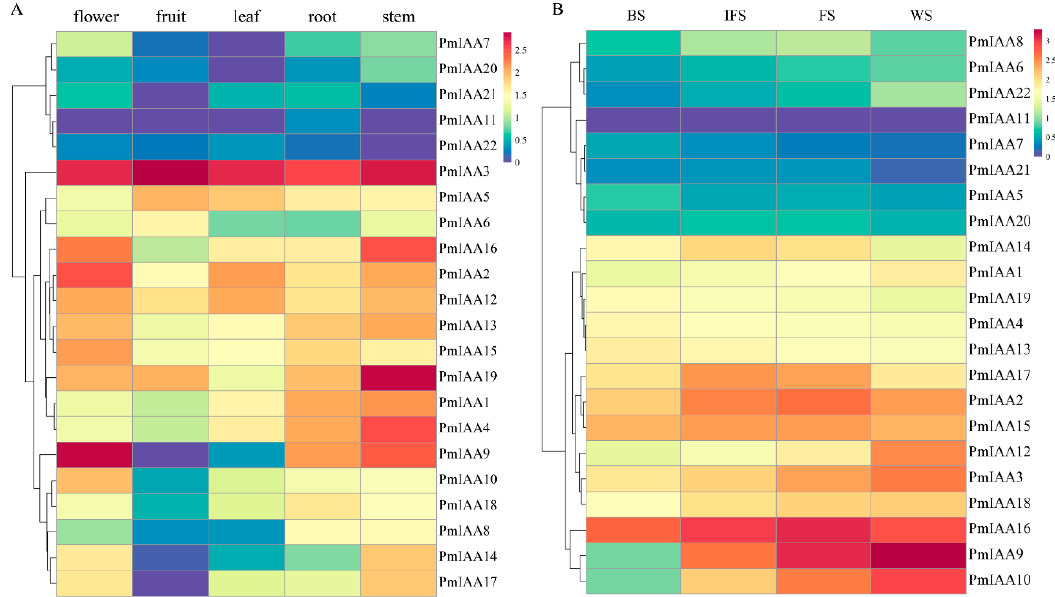
Figure 7. Heatmaps of PmIAAs expression. ( A , B ) Expression patterns of PmIAAs in five tissues and at different flowering development stages. BS: budding stage; IFS: initial flowering stage; FS: flowering stage; and WS: wilting stage. FPKM values are log10-transformed. Blue represents low expression, and red represents high expression.